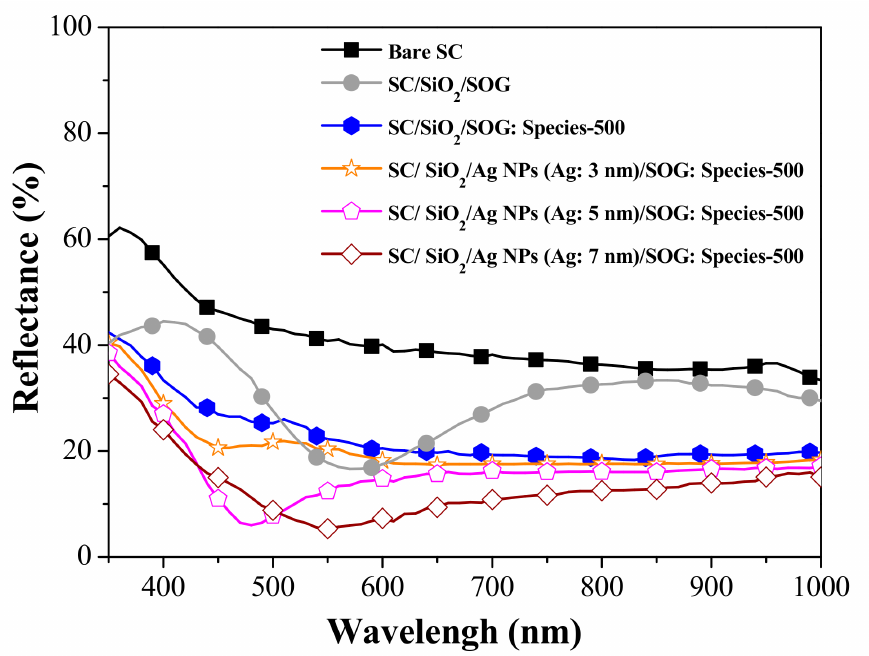
Figure 13. Optical reflectance spectra of bare silicon solar cell, cell with spacer/SOG, cell with spacer/SOG-phosphors (species-500), and cells with spacer/Ag-NPs/SOG-phosphors